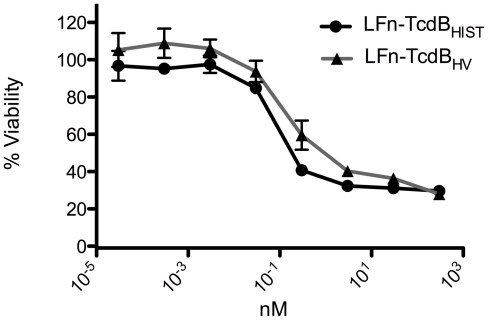
Heterologous delivery of the TcdB enzymatic domain.CHO cells were treated with LFnTcdBHIST(enz) or LFnTcdBHV(enz) in the presence of PA for 24 h and cell viability was determined by WST-8 staining. The error bars represent the standard deviation from the mean of three samples.